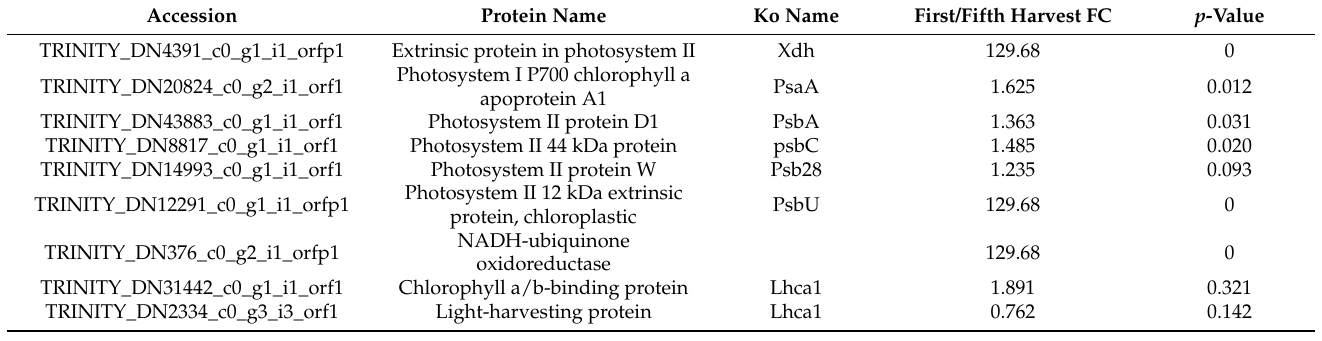
Figure 4. Correlation changes of important photosynthetic differential protein. Table 1. Differentially abundance proteins for photosynthesis in First/Fifth harvest identified by label-free proteomics.